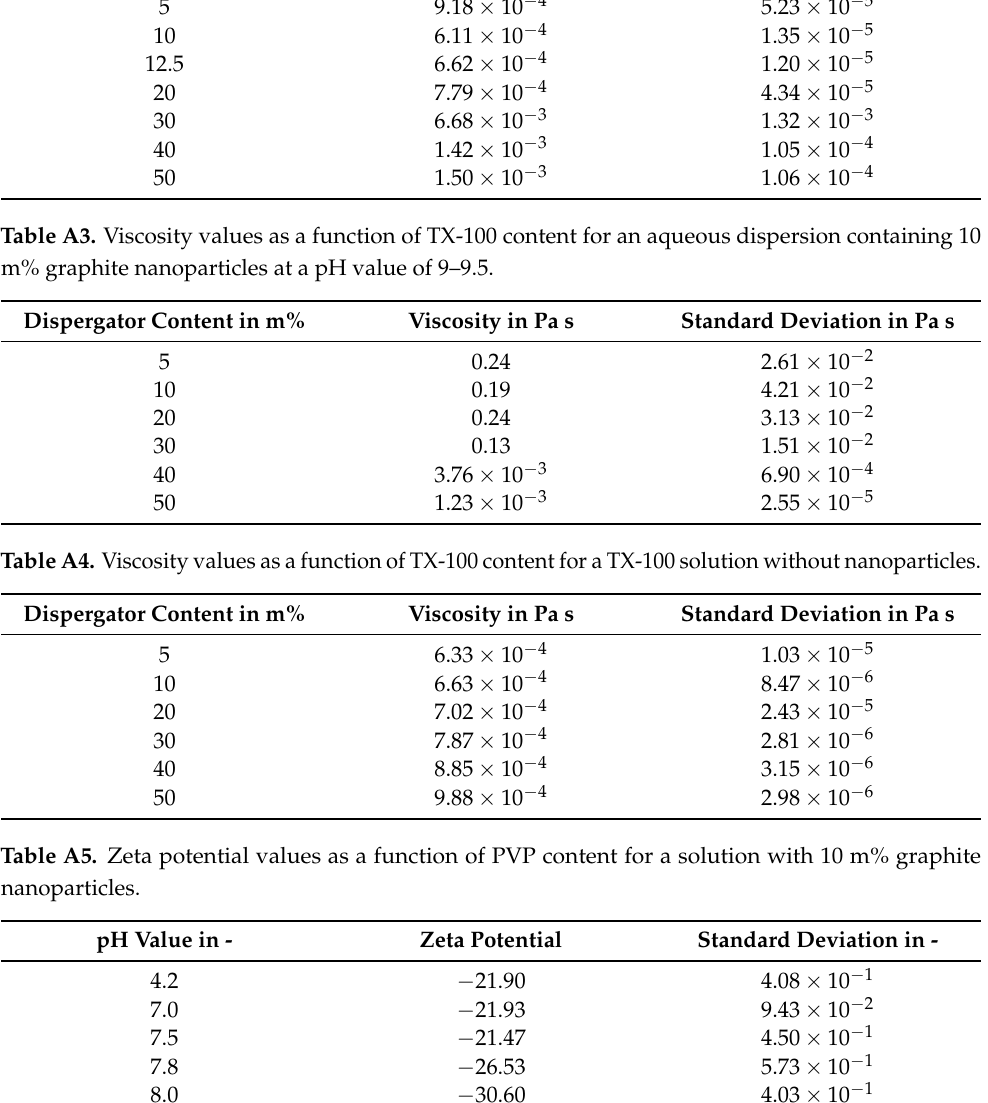
Table A2. Viscosity values as a function of PVP content for a PVP solution without nanoparticles. Dispergator Content in m%